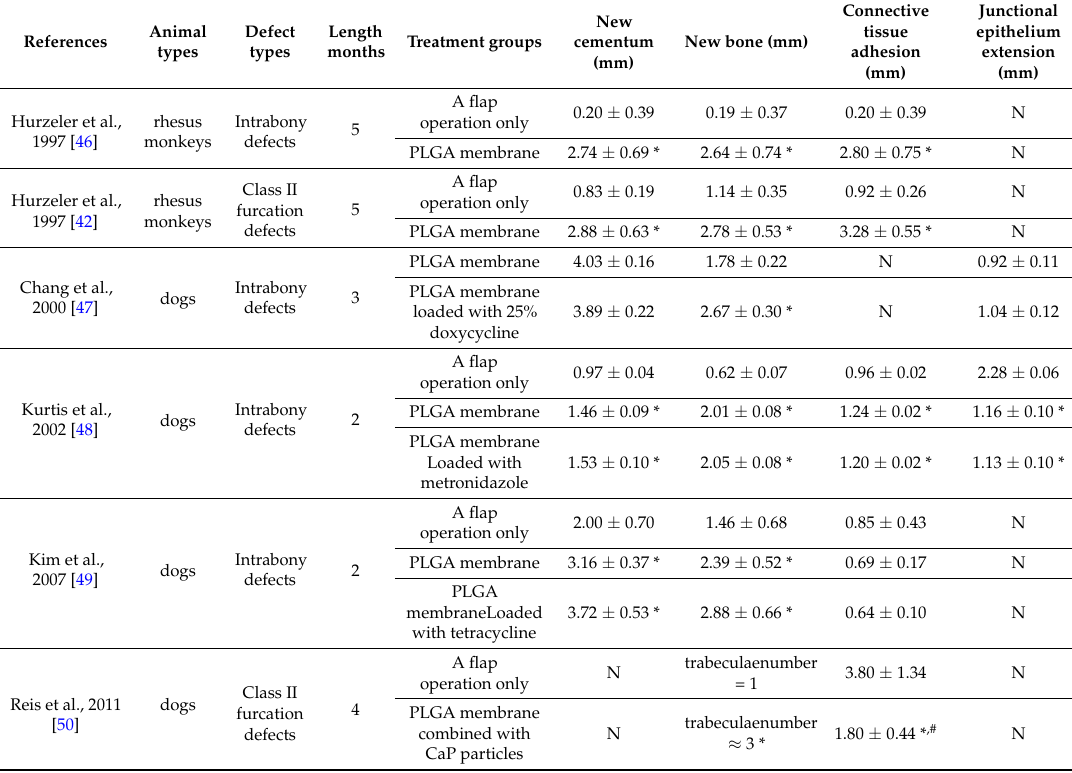
Table 2. Application of PLGA membranes in periodontal defects treatment in big animal